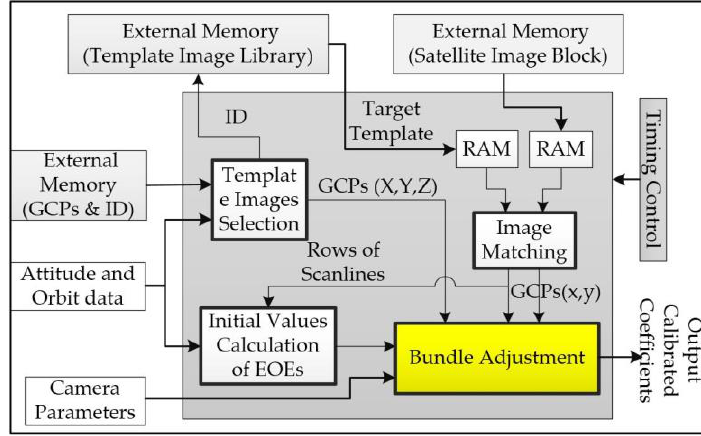
Figure 1. The FPGA architecture of geometric calibration.